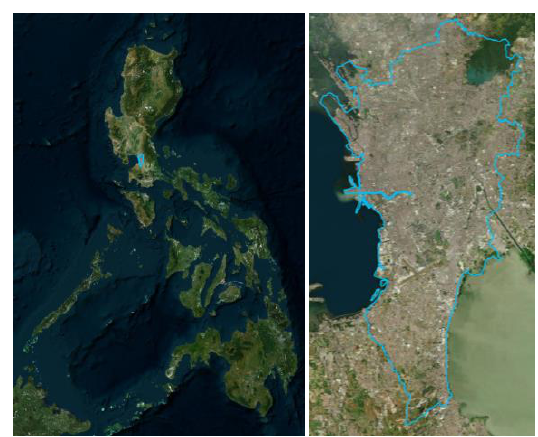
Figure 2. The National Capital Region of the